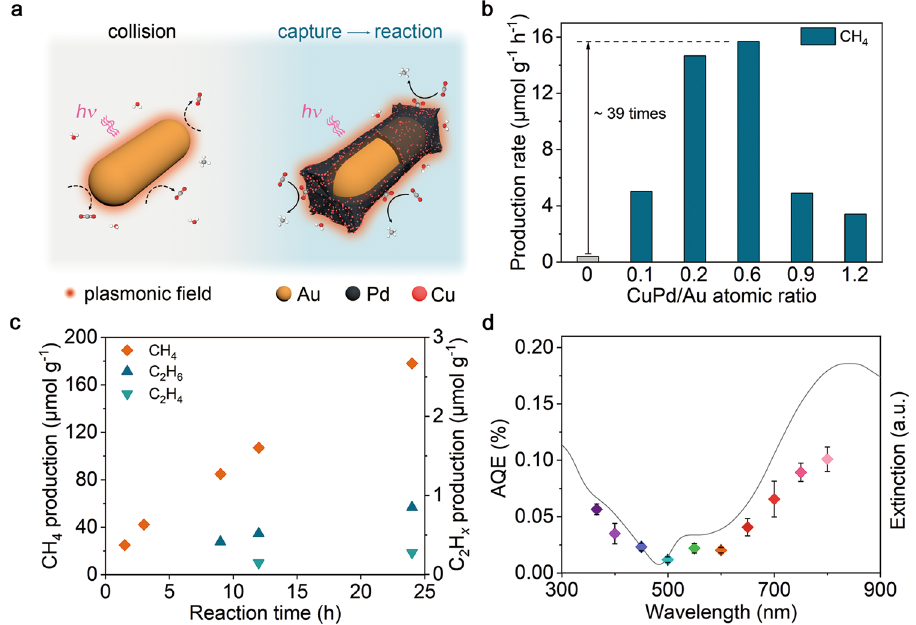
Fig.1|Plasmon-inducedCO 2 RRperformance.a Schematicillustrationoftherole of CuPd co-catalyst in capturing CO 2 molecules. Plasmonic catalysis usually takes place very close to the catalyst surface (i.e., within the range of the plasmon- induced local fi eld). For the pure Au nanorods, the probability of the pure Au nanorods and CO 2 molecules to contact through the collision is very low (left), resultinginlowCO 2 conversionef fi ciency.FortheAurod@CuPd,CuPdco-catalyst can capture CO 2 molecules and enhance the CO 2 concentration on the catalyst surface, increasing the opportunity for their further activation and conversion